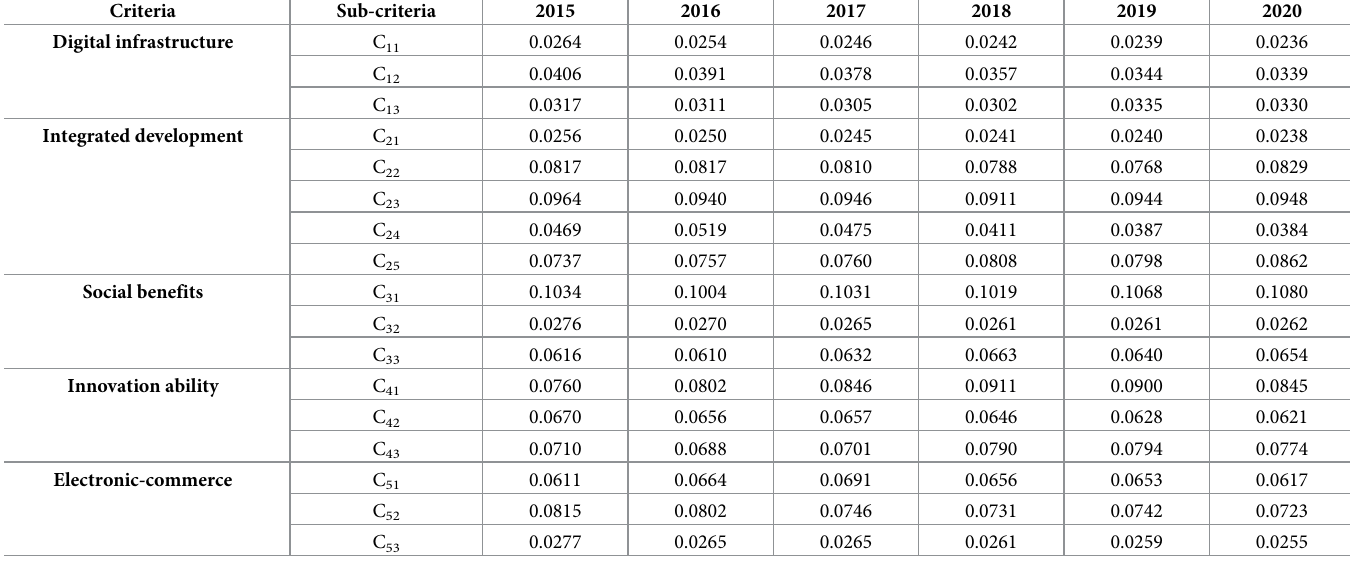
Table 3. Objective weights from 2015 to 2020 obtained via AEW